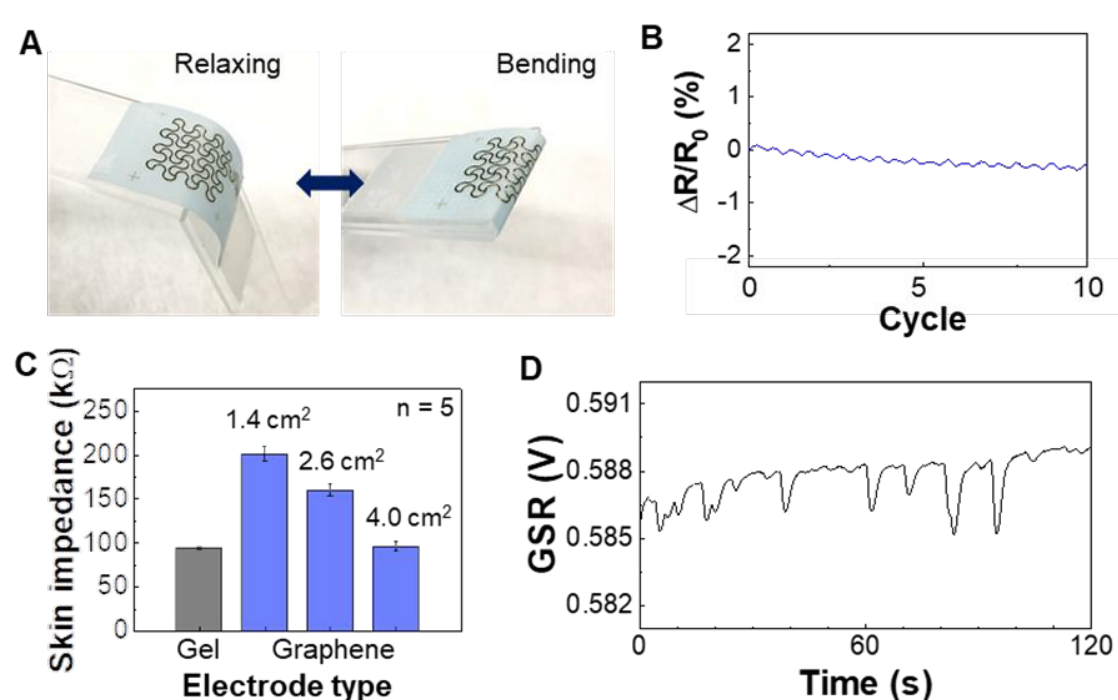
Figure 2. Characterization of mechanical and electrical properties of printed graphene electrodes. ( A ) Photos of a graphene electrode under cyclic bending. ( B ) Result of measured resistant change of the electrode in ( A ) with ten repetitive bending cycles up to 180 degrees. ( C ) Skin-electrode contact impedance on the wrist with different sizes of graphene electrodes and the comparison with a commercial gel electrode. Error bars indicate standard deviation from five trials (n = 5). ( D ) Measured GSR data from the wrist using the biggest graphene electrode (area = 4 cm 2 ) in ( C ).